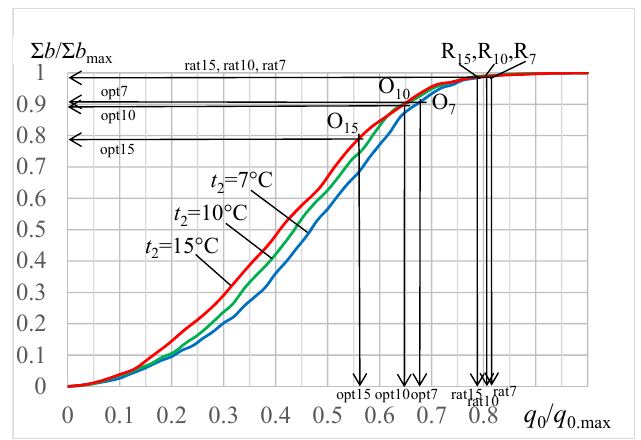
(cid:80) Figure 15. Relative values of annual fuel reduction ∑ b/b max against relative cooling capacities q 0 / q 0.max b / b max against relative cooling capacities q 0 / q 0.max Figure 15. Relative values of annual fuel reduction needed for cooling ambient air to t a 2 = 7, 10 and 15 °C. needed for cooling ambient air to t a 2 = 7, 10 and 15 ◦